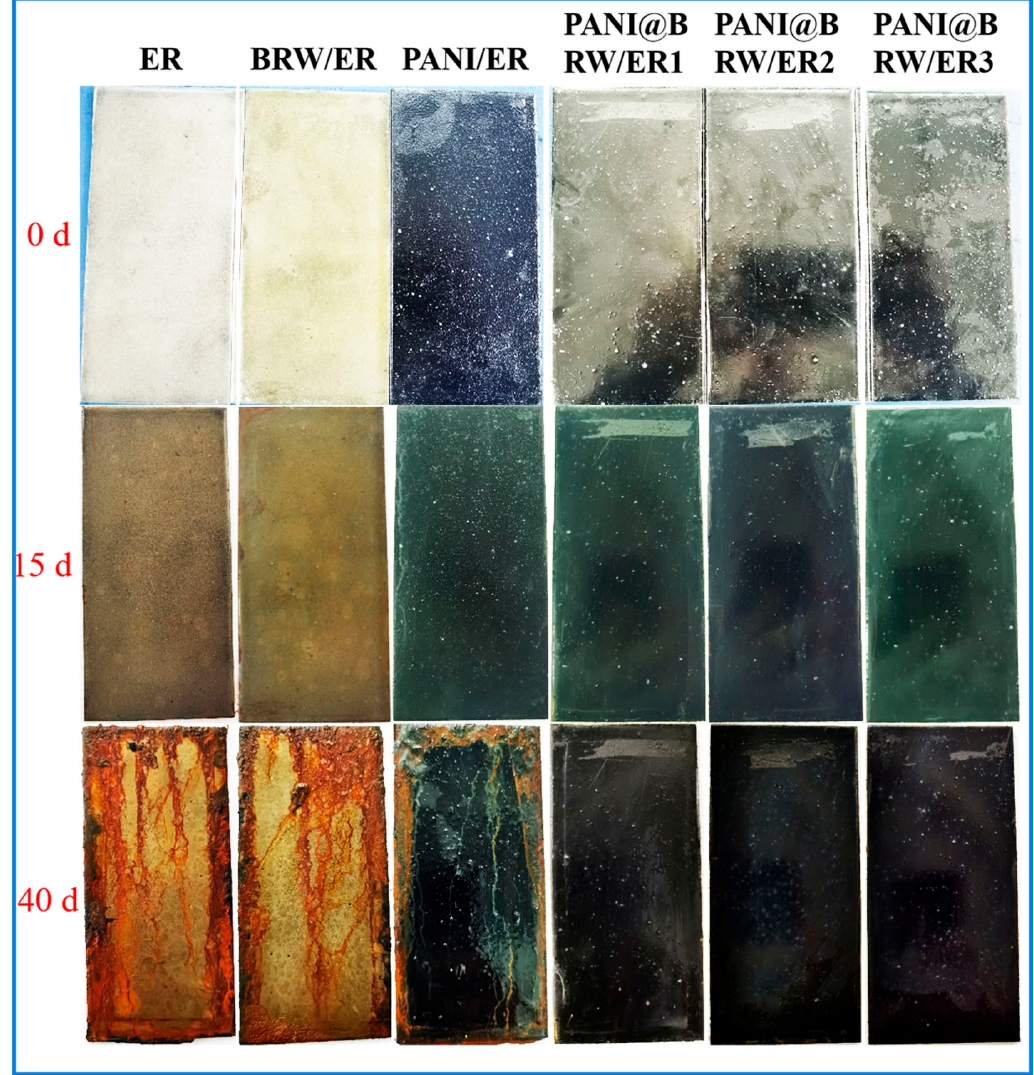
Figure 8. Images of ER, BRW/ER, PANI/ER, PANI@BRW/ER1, PANI@BRW/ER2, and PANI@BRW/ER3 coatings subjected to salt spray test after 0 d, 15 d, and 40 d, respectively.